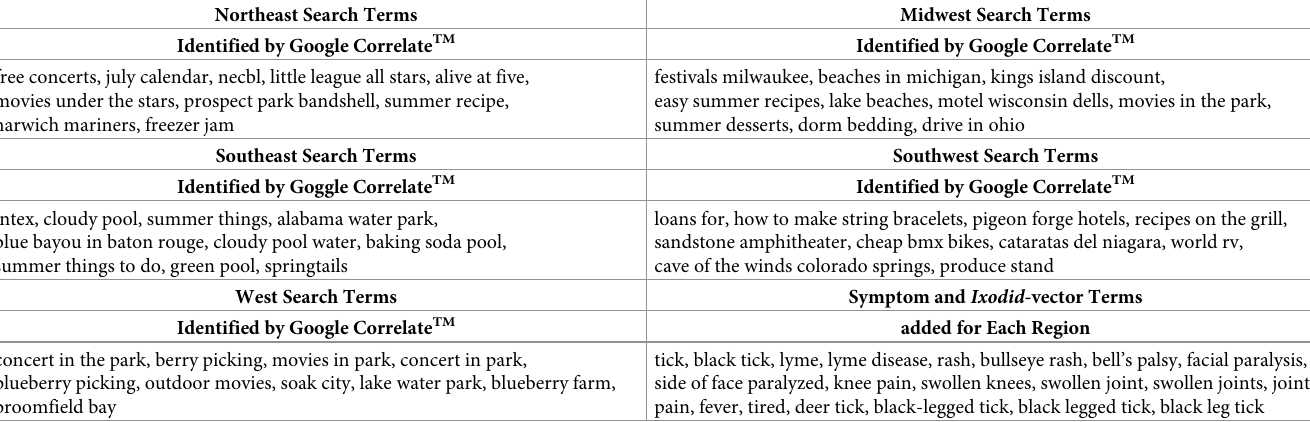
Table 1. Candidate search terms identified via Google Correlate TM by region with symptom/vector terms.